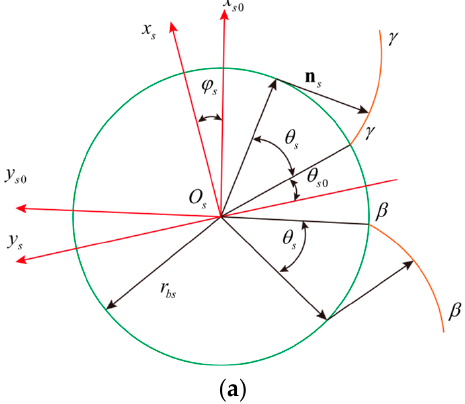
Figure 2. Diagrams showing the processing of the face gear: ( a ) parameters of the involute surface of the gear cutter and ( b ) generating coordinate system of face gear.